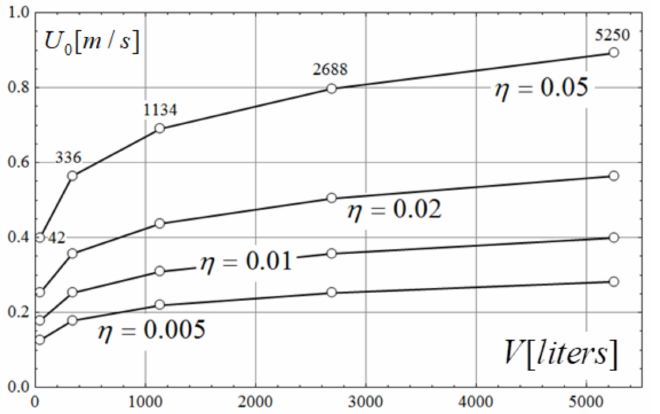
Figure 5. Speed on the trajectory versus the volume of the FW type vehicle for different magnitudes of relative differential buoyancy η ( C y =